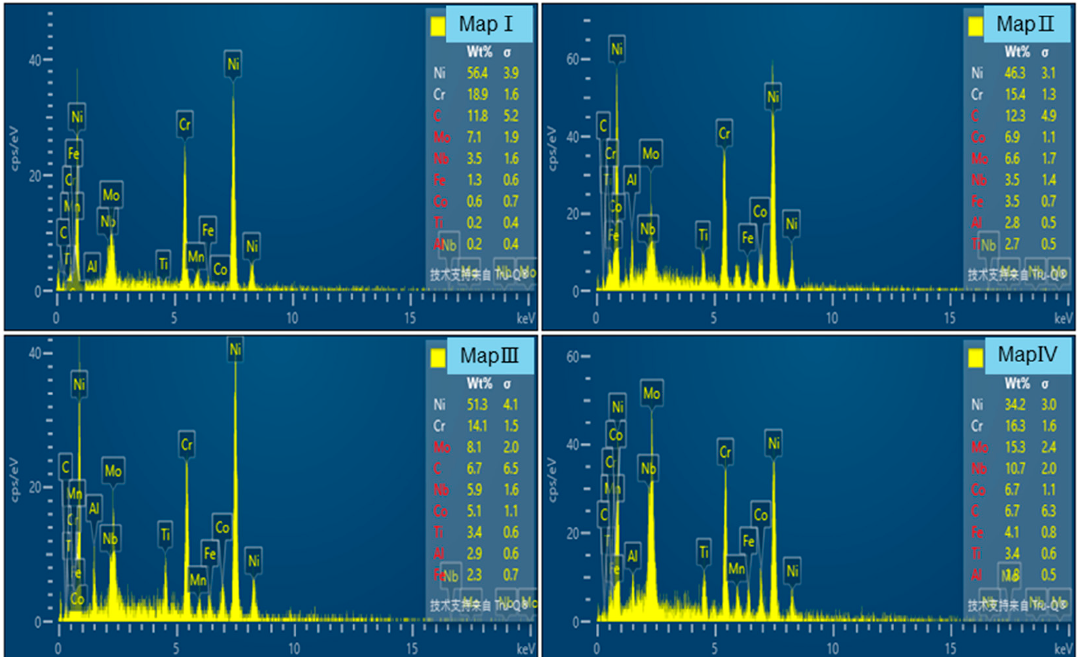
Figure 4. EDS results of the four micro-regions in Figure 3 (Map Ⅰ : Region Ⅰ in Figure 3; Map Ⅱ: Region ⅠI in Figure 3; Map Ⅲ : Region Ⅲ in Figure 3; Map Ⅳ : Region Ⅳ in Figure 3).